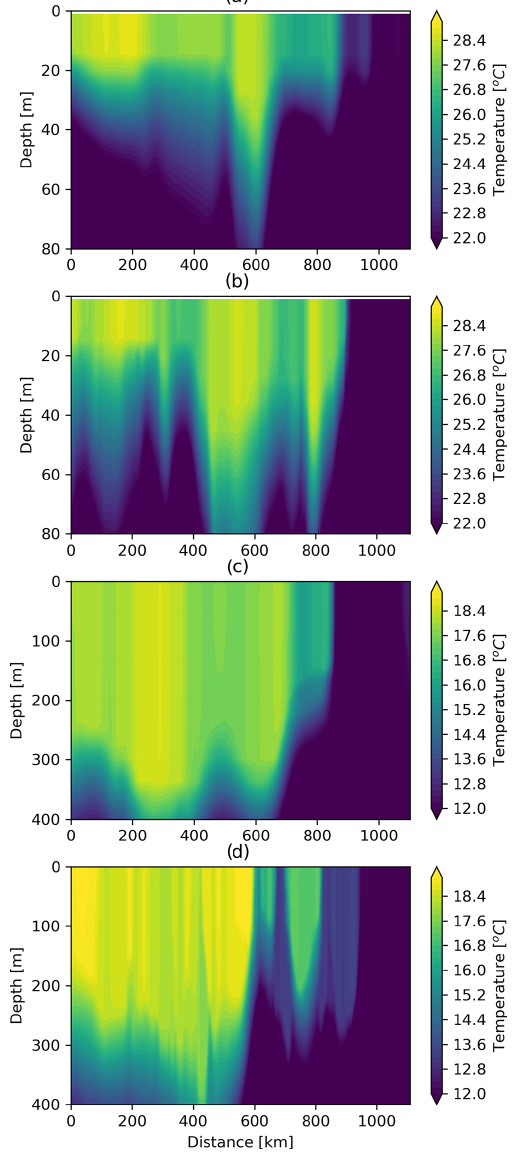
Figure A4. Temperature along the section in the Kuroshio Exten- sion region of 1 / 10 (a, c) and 1 / 32 ◦ (b, d) models during summer (a, b) and winter (c, d) , respectively. Figures A3 and A4 show the evolution of relative vorticity and temperature along a typical sec- tion in the Kuroshio Extension region, which is shown in Fig. 6a. The typical horizontal scale of resolved fronts in the 1 / 10 ◦ model is about 60km, and the horizontal scale in the 1 / 32 ◦ model is about 3 times smaller ( ∼ 20km). The vertical scales of the resolved fronts of both the 1 / 10 model and 1 / 32 ◦ model are quite similar, and the summer (winter) has a vertical scale of about 30m (300m).